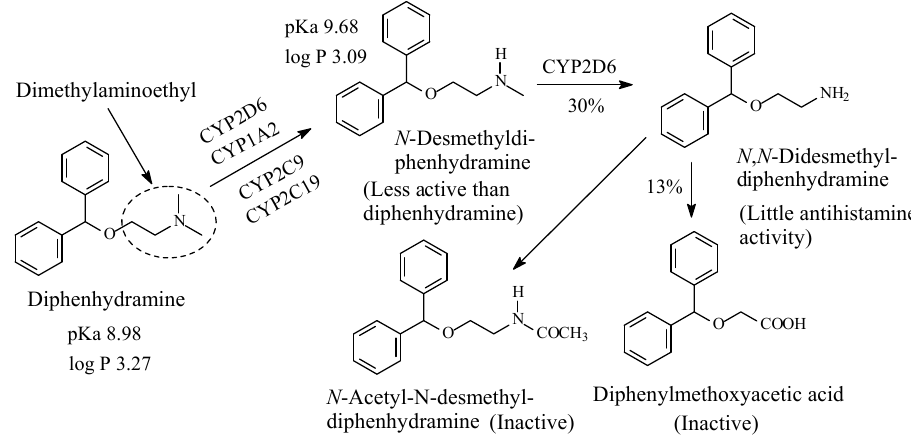
Figure 22. Metabolic pathways of